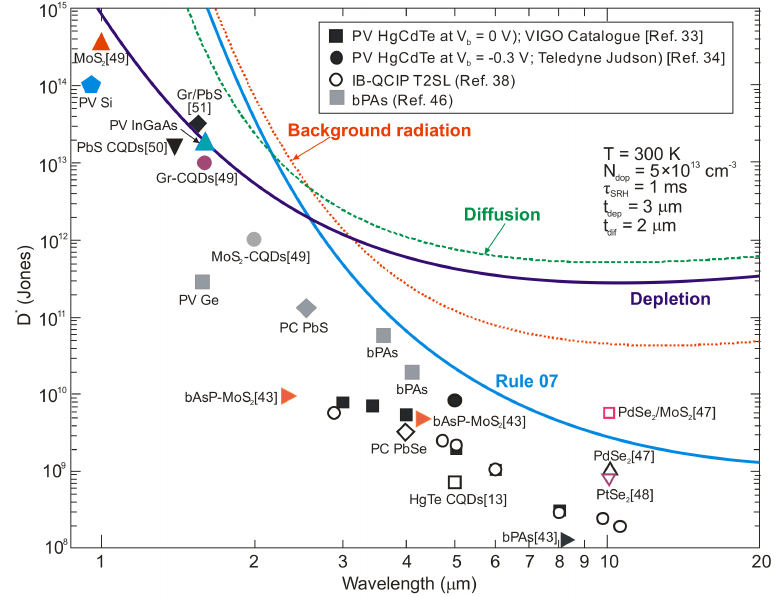
Figure 12. Detectivity, D * versus wavelength for the commercially available room-temperature IR photodetectors (PV Si and Ge, PV InGaAs, PC PbS and PbSe, PV HgCdTe). There is also included experimental data for IB QCIP T2SLs, different type of 2D material and CQD photodetectors taken from literature as marked. The theoretical curves are calculated for the P-i-N HOT HgCdTe devices assuming τ SRH = 1 ms, the absorber doping 5 × 10 13 cm − 3 and the active region thickness t = 5 µ m. Experimental data is taken from [13,33,34,38,43,46–51]. PC—Photoconductor,